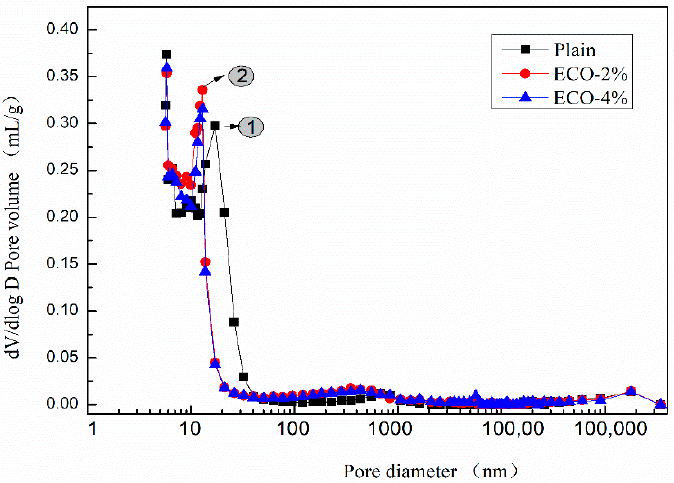
Figure 8. dV / dlog D pore size Figure 8. dV/dlog D pore size distribution.